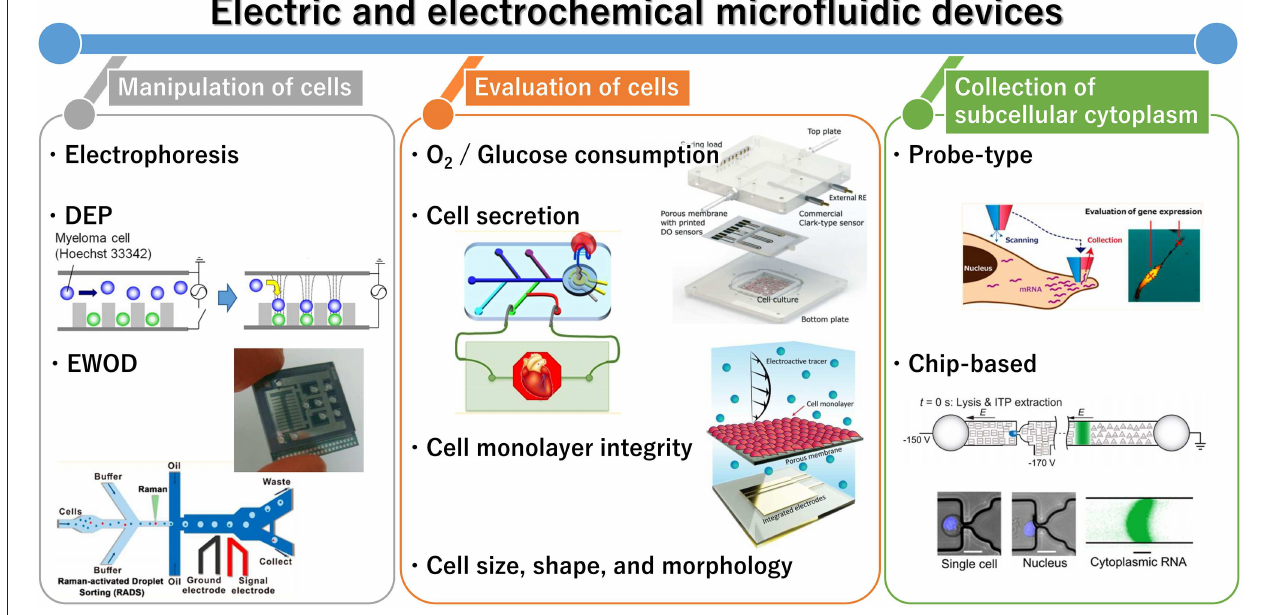
FIGURE 1 | General outline of electric and electrochemical microfluidic devices for cell analysis. Reprinted with permission from Yoshimura et al. (2014); Nashimoto et al. (2016); Shin et al. (2016); Wang et al. (2017). Copyright (2014, 2016, and 2017) American Chemical Society. Reprinted with permission from Rival et al. (2014); Moya et al. (2018); Wong and Simmons (2019) . Reproduced from Abdelmoez et al. (2018).